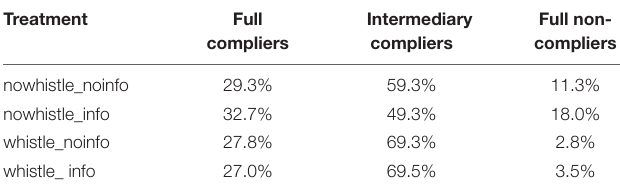
TABLE 1 | Proportion of full compliers, intermediary and full non-compliers per